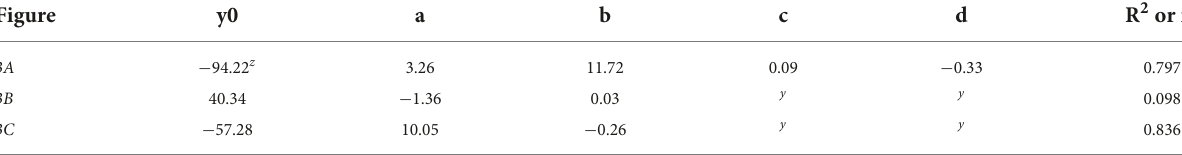
z Coefficientsformodelequationswereusedtogenerate Figure3A through Figure3C . y